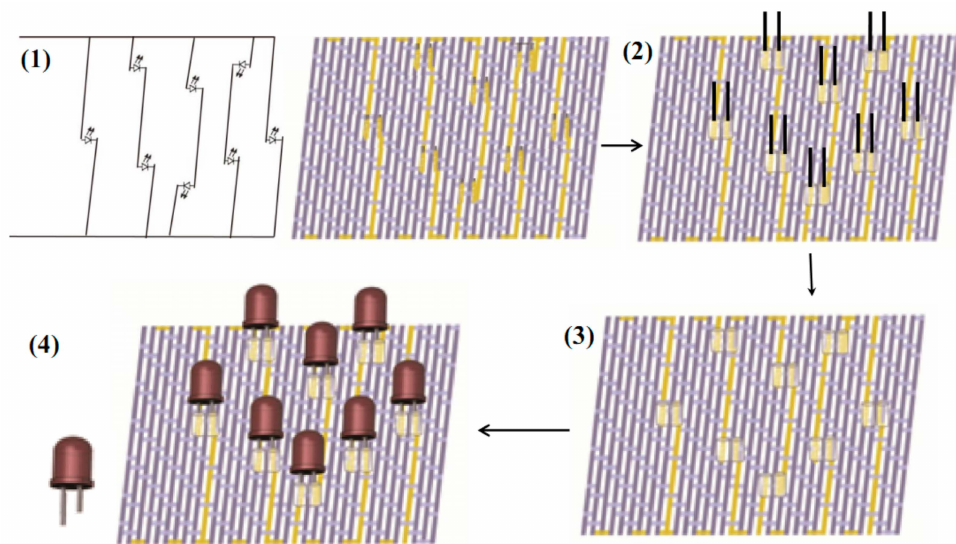
Figure 9. Primary processes of the FCB assembly. ( 1 ) Design and fabrication of the FCB according to the layout corresponding to pre-determined positions of the LEDs; ( 2 ) Fabrication of helical connections by wrapping SCPY around the needles with encapsulated elastomers; ( 3 ) Naked FCB with connection holes; ( 4 ) Formed FCB with inserted LEDs.